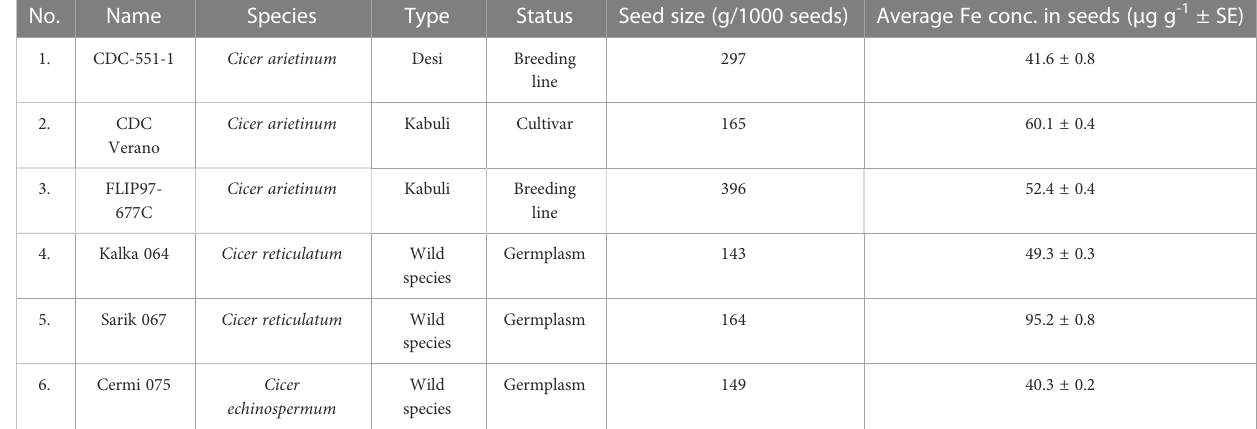
TABLE 1 Description of six chickpea genotypes with the seed size (g/1000seeds) and mean Fe concentration in seeds (µg g -1 ± SE) evaluated in the study of Fe absorption and accumulation in different organs.